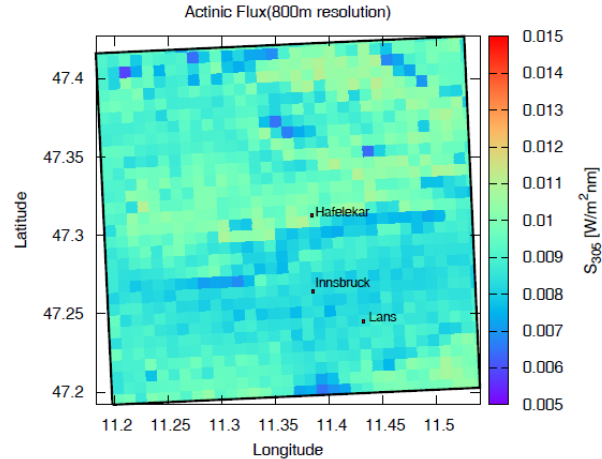
Fig. 6. 3-D radiative transfer simulation of the 305nm actinic flux Figure 6: 3-D radiative transfer simulation of the 305 nm actinic flux on 24 th February 2008 on 24 February 2008 08:20UTC (70 degree solar zenith angle) us- 8:20 UTC (70 degree solar zenith angle) using a DEM with 50 m resolution for the Innsbruck ing a DEM with 50m resolution for the Innsbruck area. area.